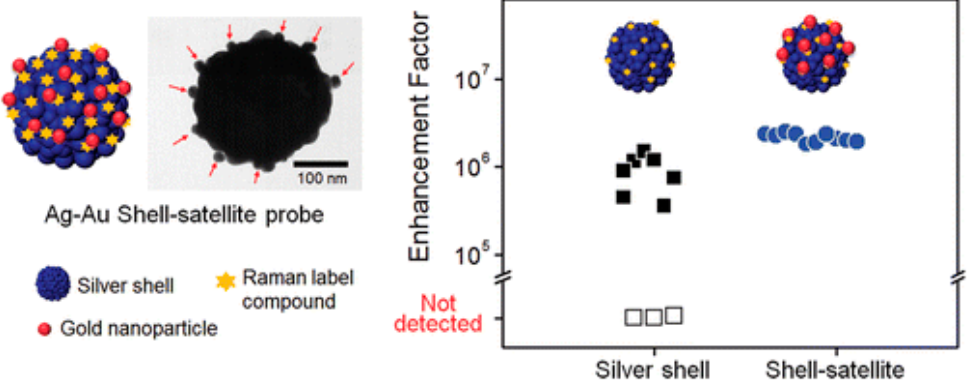
Figure 39. Drawing of Ag-Au heterosatellitallic shell–satellite structure and its optical properties [156].